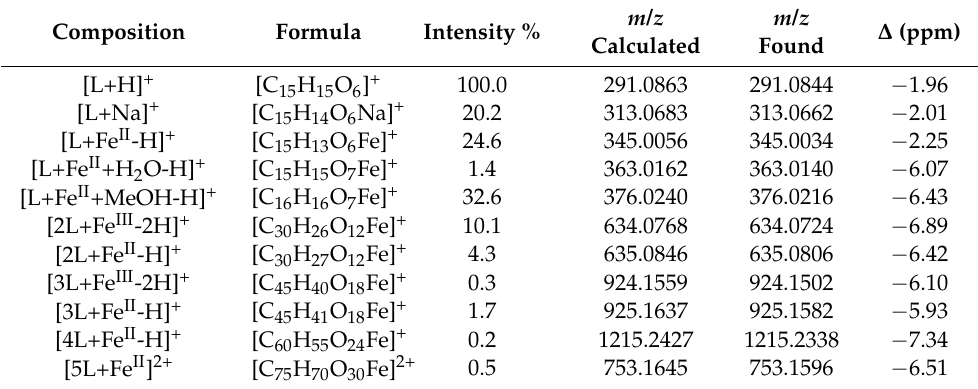
Table 1. The main signals of 56 Fe-catechin coordination complexes in the solutions of ( ± )-catechin with Fe II analyzed by nano-ESI–MS, positive ionization mode.